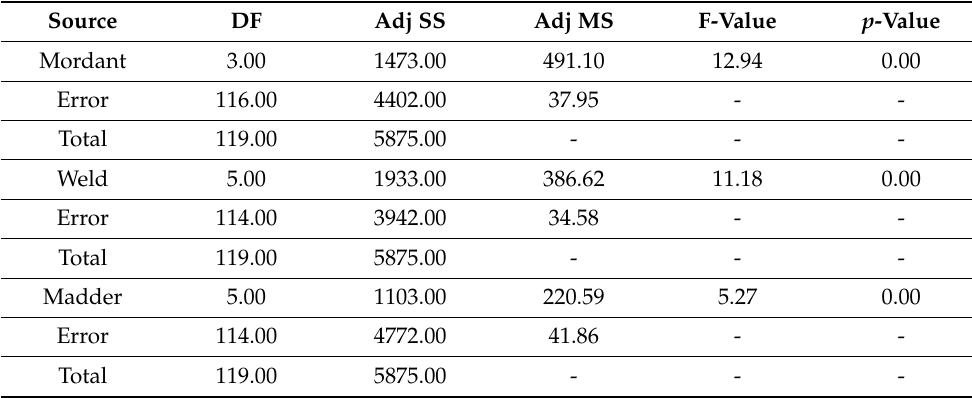
Table 3. Results of ANOVA for b* color